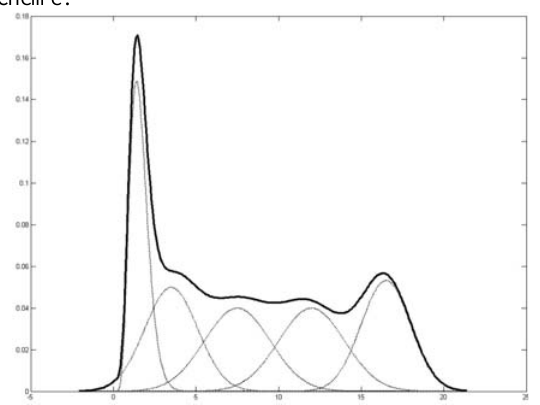
Fig. 1. Reference PDF. Grey lines: PDF components (four Gaussian and one Gamma functions). Black line: reference PDF (sum of